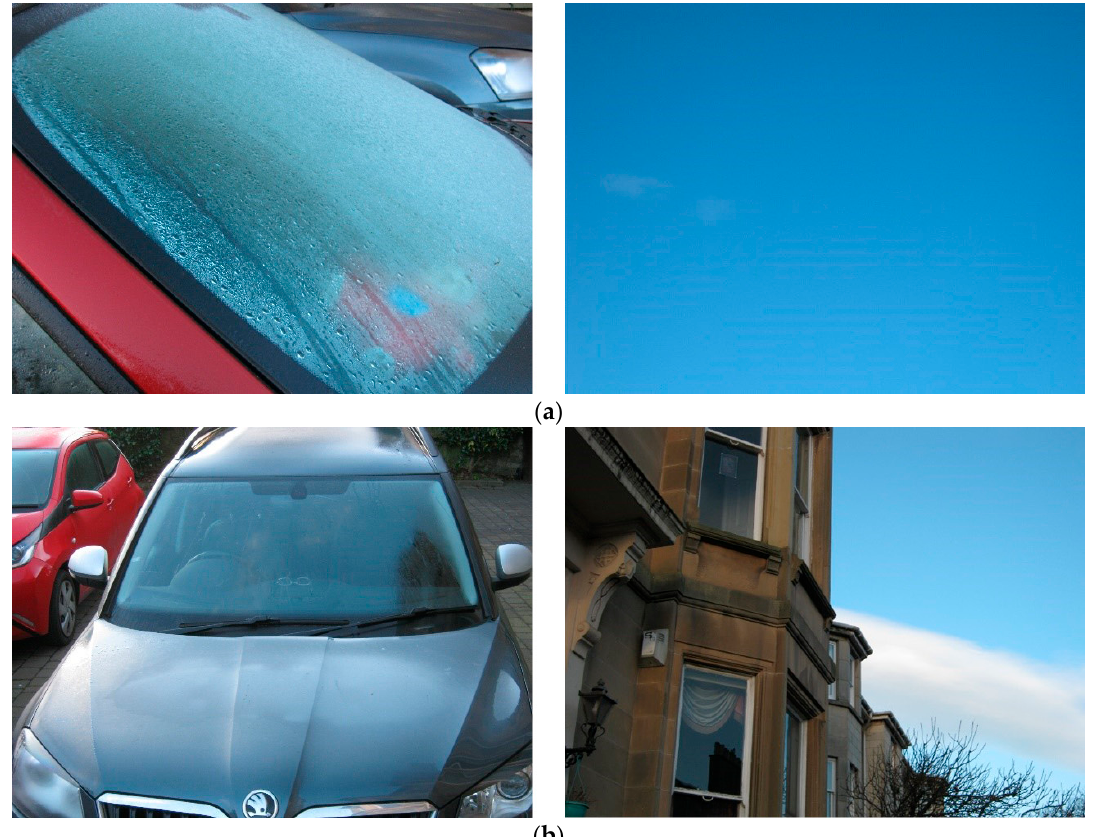
Figure 1. Pictures that demonstrate the temperature difference of car windscreens that have different objects in their view. The top windscreen ( a ) acquiring a much lower temperature owing to its view factor that includes only sky. The lower windscreen ( b ) view is dominated by building surfaces that have a much higher temperature. Note: clear sky at night acquires a high absorptivity and a much lower temperature.